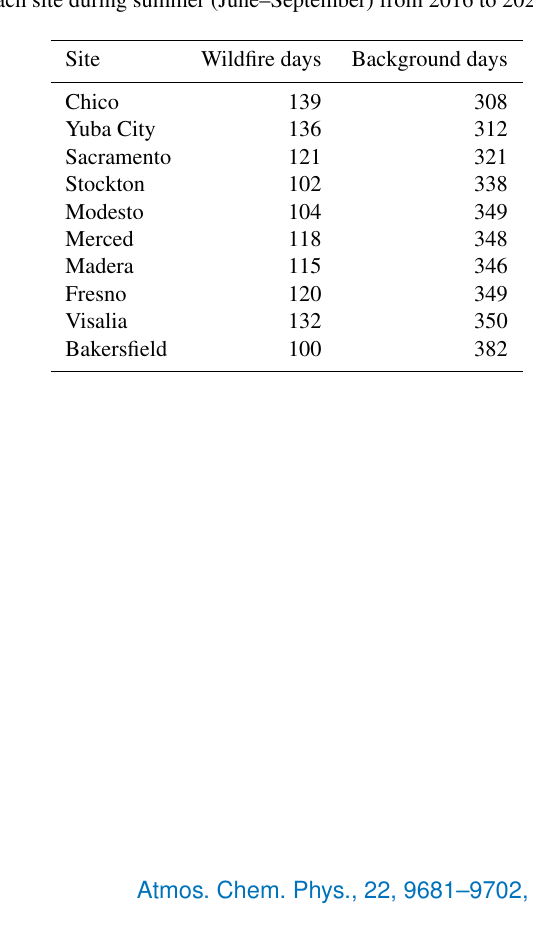
Table C2. Number of wildfire-influenced and background days at each site during summer (June–September) from 2016 to